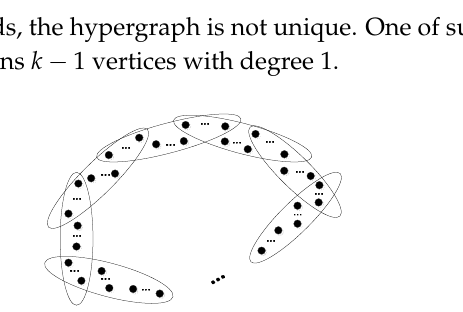
Figure 7. An r -uniform GHT with the minimum number of edges with ω = k , and each. edge contains Figure 7. An r ‐ uniform GHT with the minimum number of edges with  ω k , and each. edge k − 1 vertices with degree contains 1  k vertices with degree 1.